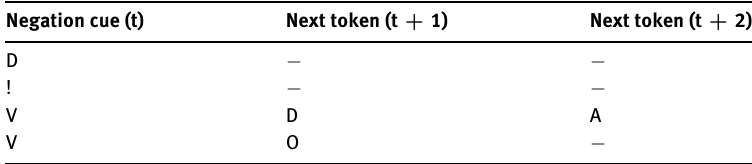
Table 1: Negation Exception Patterns from Negative Rhetoric